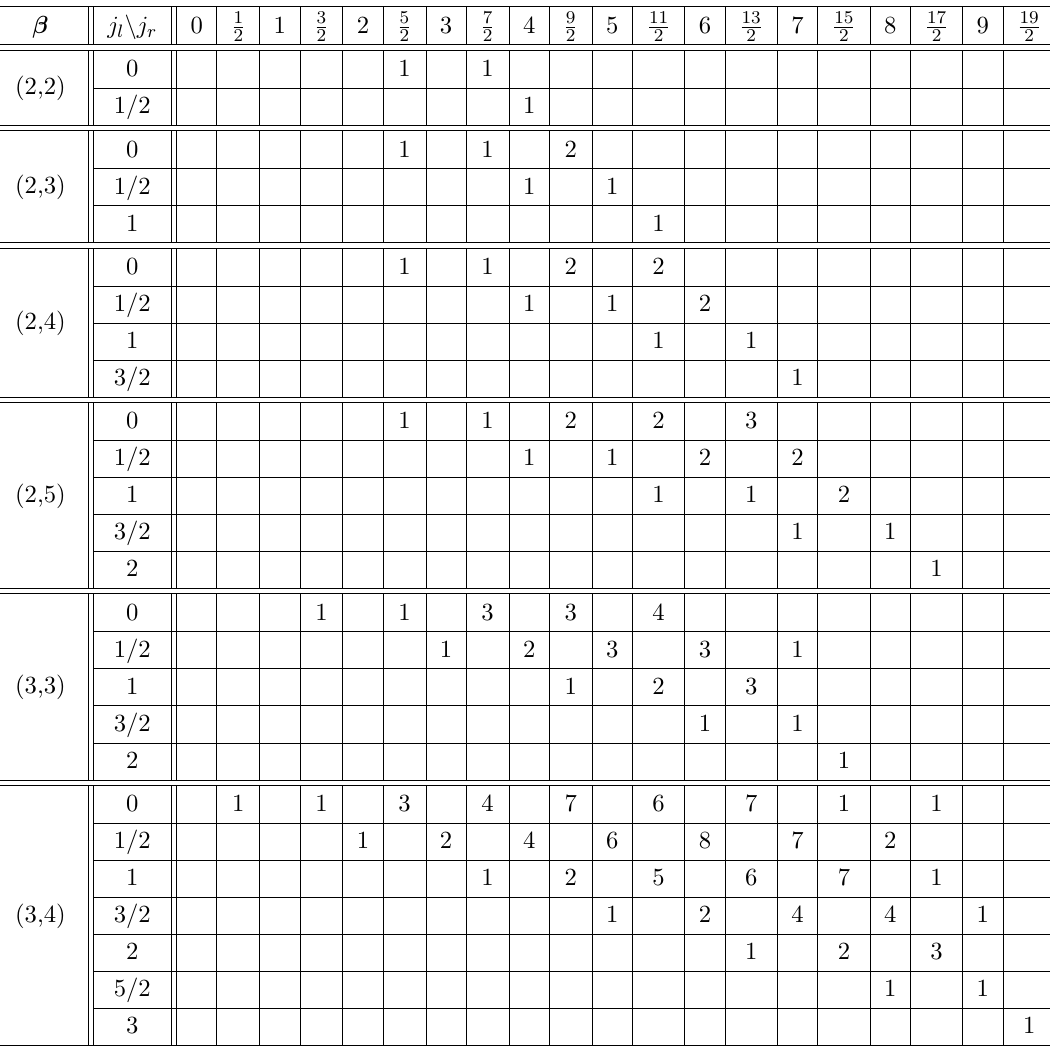
Table 1 . Refined GV invariants N β